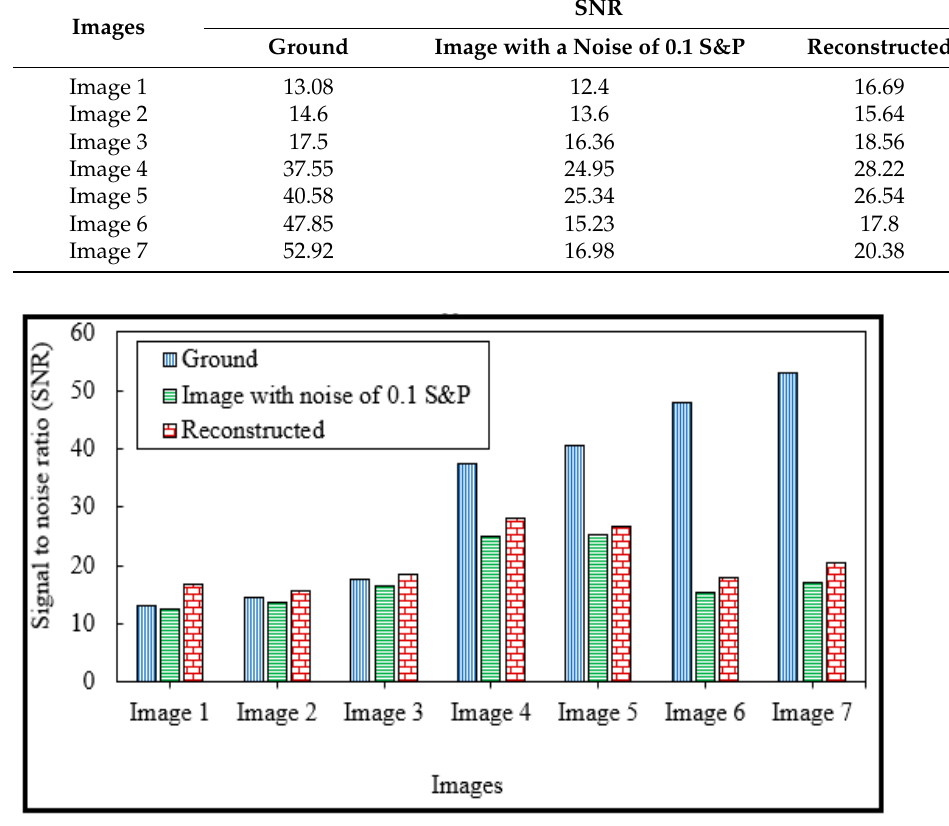
Figure 7. Comparison of SNR ground image, Noise image, and reconstructed images.